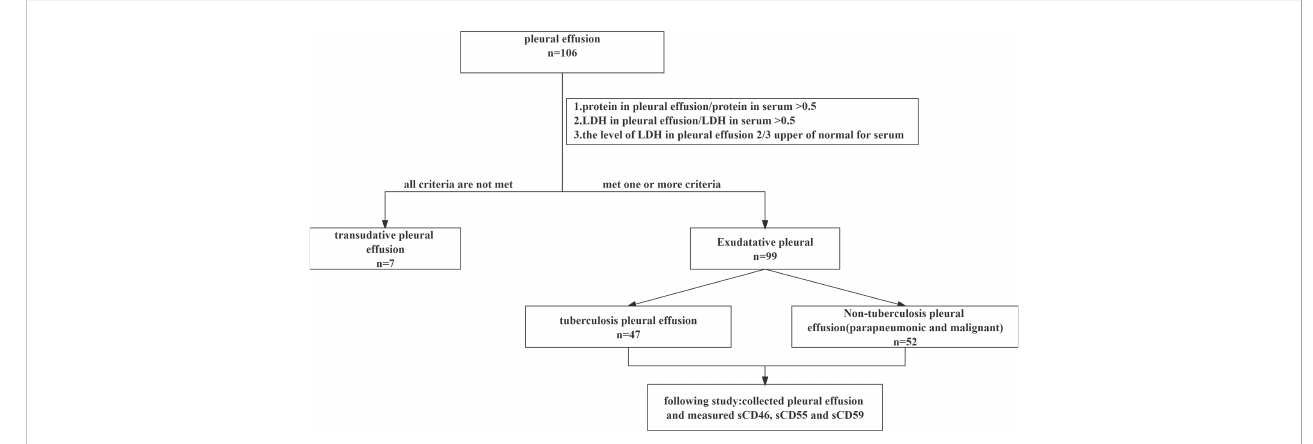
FIGURE 1 Flow chart showing the selection of